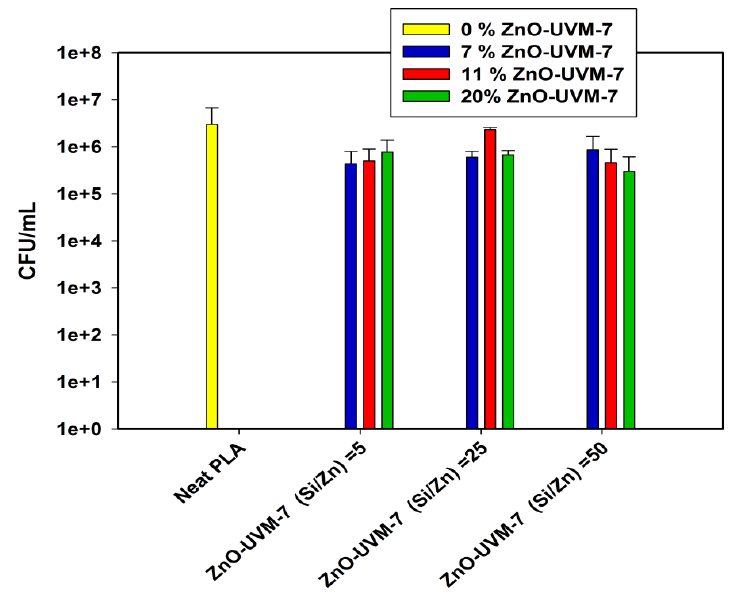
Figure 5. ABA of electrospun PLA/ZnO-UVM-7 nanofibers with different ZnO-UVM-7 content, for 3 different molar ratio (5, 25, and 25), against E. coli (DH5α), after incubation at 37 °C for 4 h in phosphate-buffered saline solutions. Data are shown with mean values and standard errors of bacterial counts.